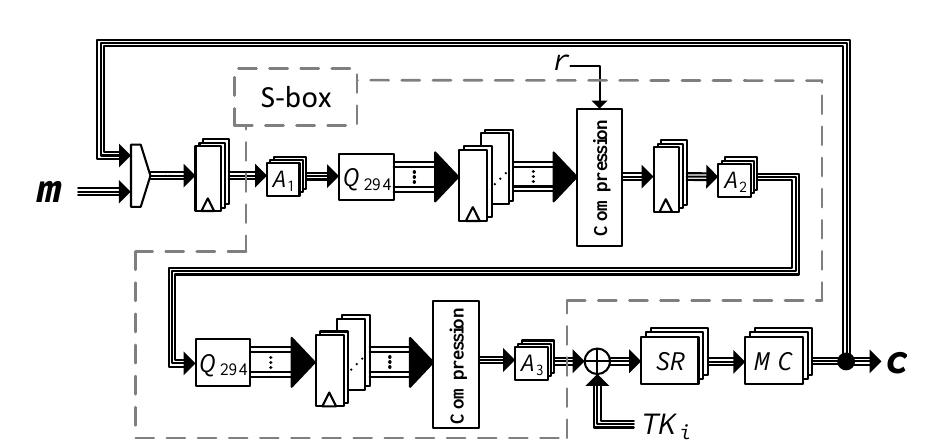
Figure 2: Design architecture of our round-based second-order SKINNY-64 encryption